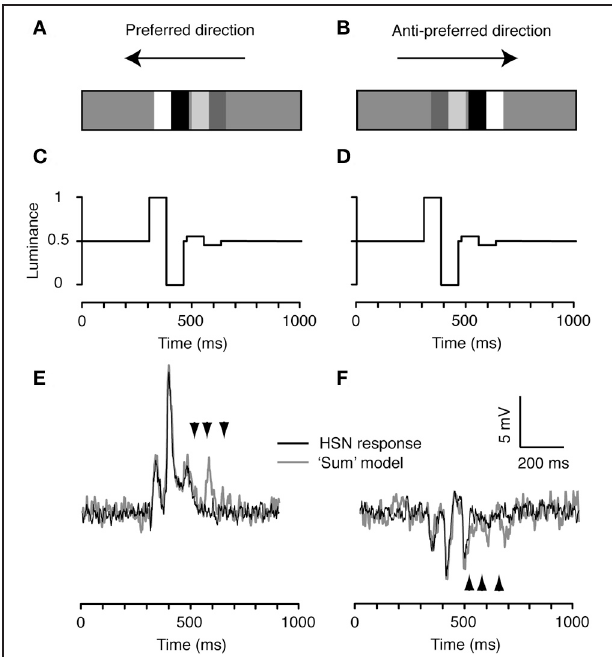
FIGURE 4 | The decreasing contrast pair. (A) We combined the high and low contrast doublets to produce an ensemble with the high-contrast doublet preceding the low contrast doublet. (B) The spatial arrangement is flipped for stimulation in the anti-preferred direction so that the temporal order of contrast changes remains the same. (C) Time-luminance trace for motion in the preferred direction. (D) Time-luminance trace for motion in the anti-preferred direction. (E) HS response to the decreasing contrast pair moving in the preferred direction. The gray line indicates the predicted response based on the linear sum of the response to each individual doublet (see Figure 2 ). The arrowheads highlight the timing of the three peaks to the second doublet, predicted from the model output (see Figure 2 ). (F) Intracellular response of an HS neuron to the pair moving in the anti-preferred direction. The gray line indicates the linear sum of the response to the individual doublets (see Figure 2 ). The arrowheads highlight the timing of the three peaks to the second doublet, predicted from the model output. n = 20 from the same neuron as shown in Figures 2 and 3